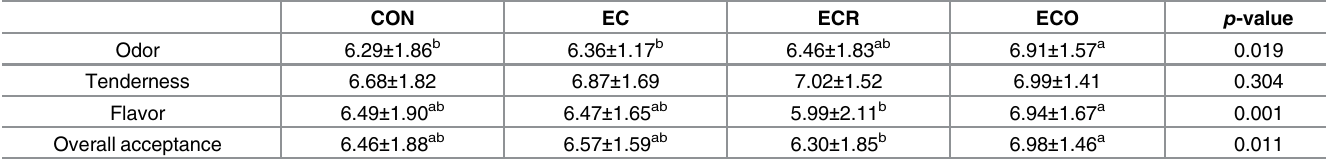
Table 5. Consumer (n = 90) acceptability § of coated and uncoated